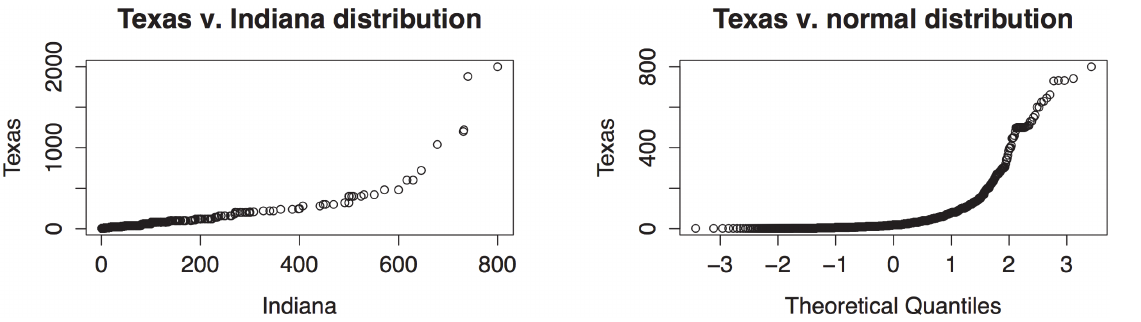
Fig 2. Q-Q Plots showing (left) that the data is different from survey to survey and (right) that the data is also non-normal. In each panel, if the two samples were drawn from the same distribution, the plotted points would lie approximately on the diagonal line joining the lower-left and upper-right